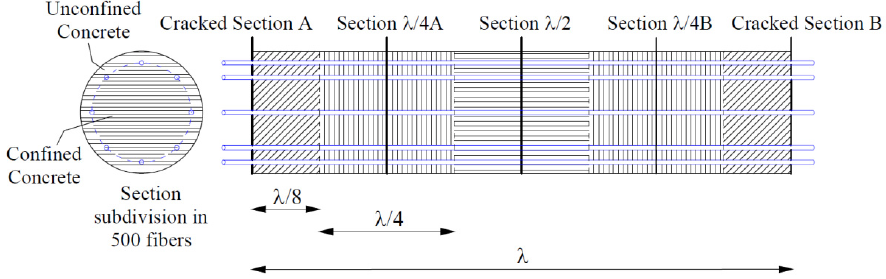
Figure 7. Element portion comprised between two consecutive cracks: ( a ) Fibers of the circular section; ( b ) sections studied for the evaluation of the total rotation.